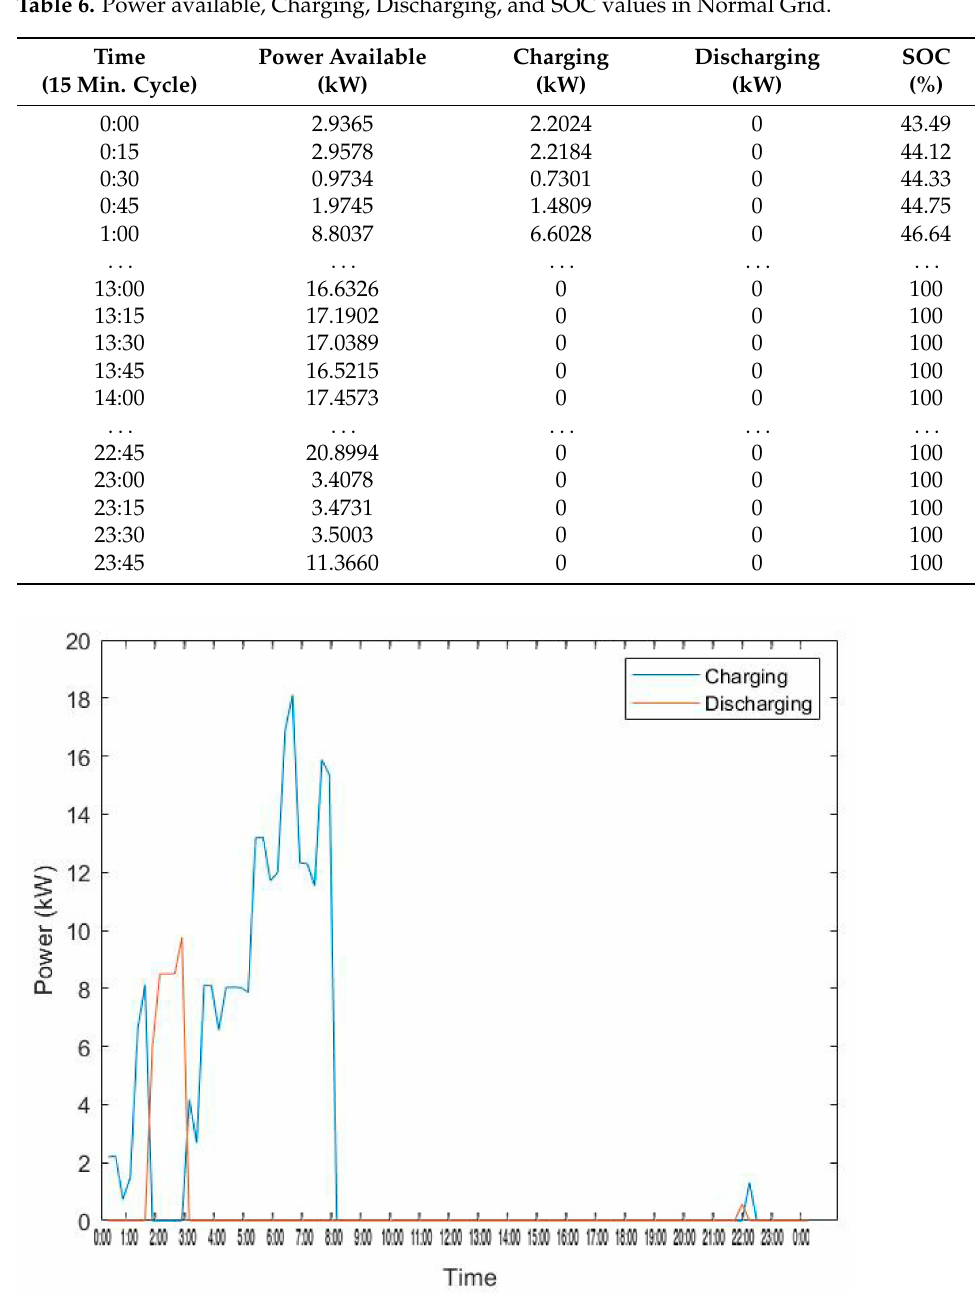
Figure 12. Charging and Discharging value in Normal